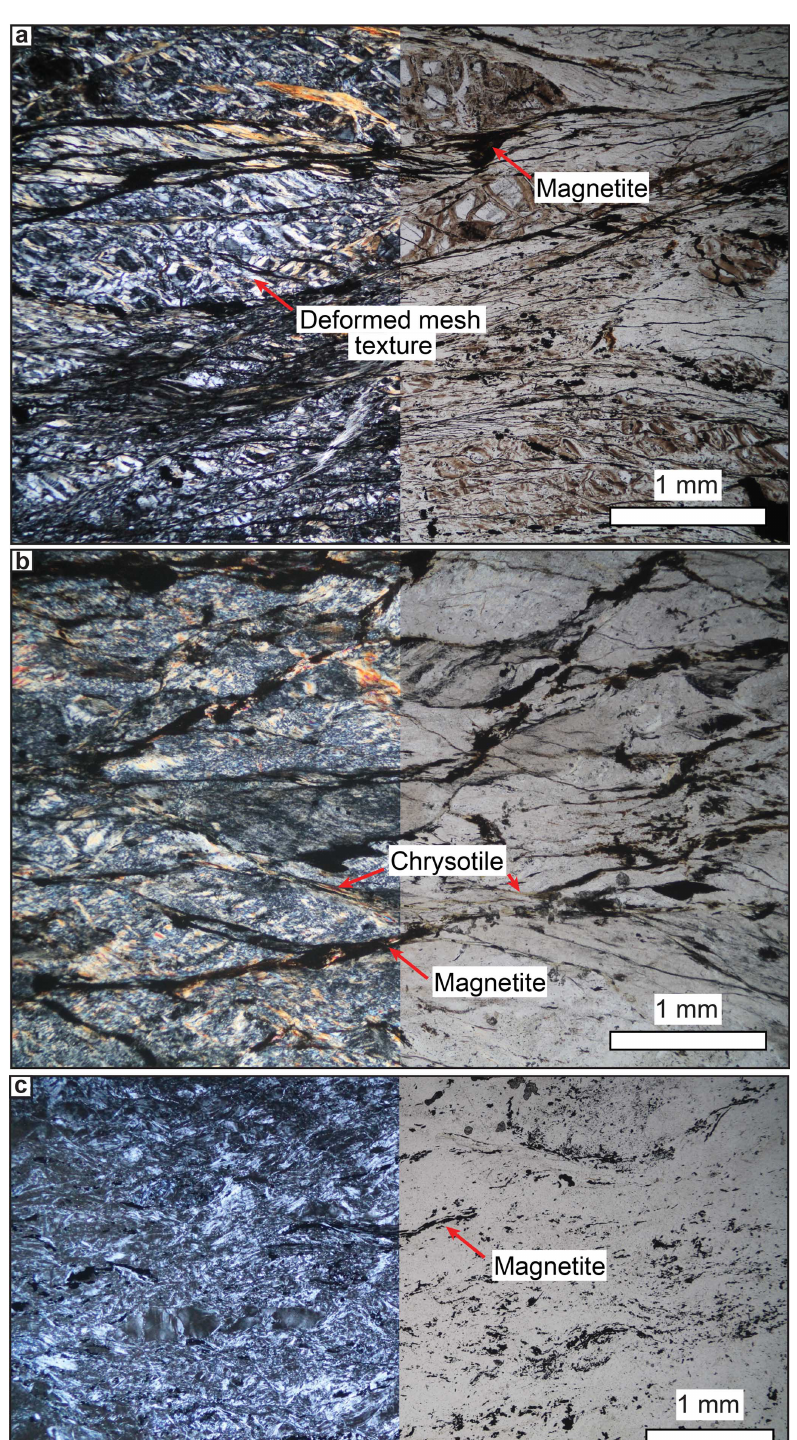
Figure 10. Evolution of serpentinite texture and mineralogy in scaly shear zone serpentinites. Each figure shows an optical microscope image in crossed-polarised light (left-hand side) and plane-polarised light (right-hand side). (a) Where the scaly foliation is relatively widely spaced, magnetite-bound phacoids preserve weakly deformed mesh-textured serpentinite composed of lizardite and chrysotile. (b) Where the scaly foliation is more closely spaced, no recognisable pseudomorphic textures are preserved. Continuous seams of magnetite outline the scaly foliation. (c) In samples of well-developed scaly serpentinite with lower proportions of magnetite, discontinuous seams of magnetite are concentrated at the boundaries of the scaly foliation, broadly defining lenticular domains of